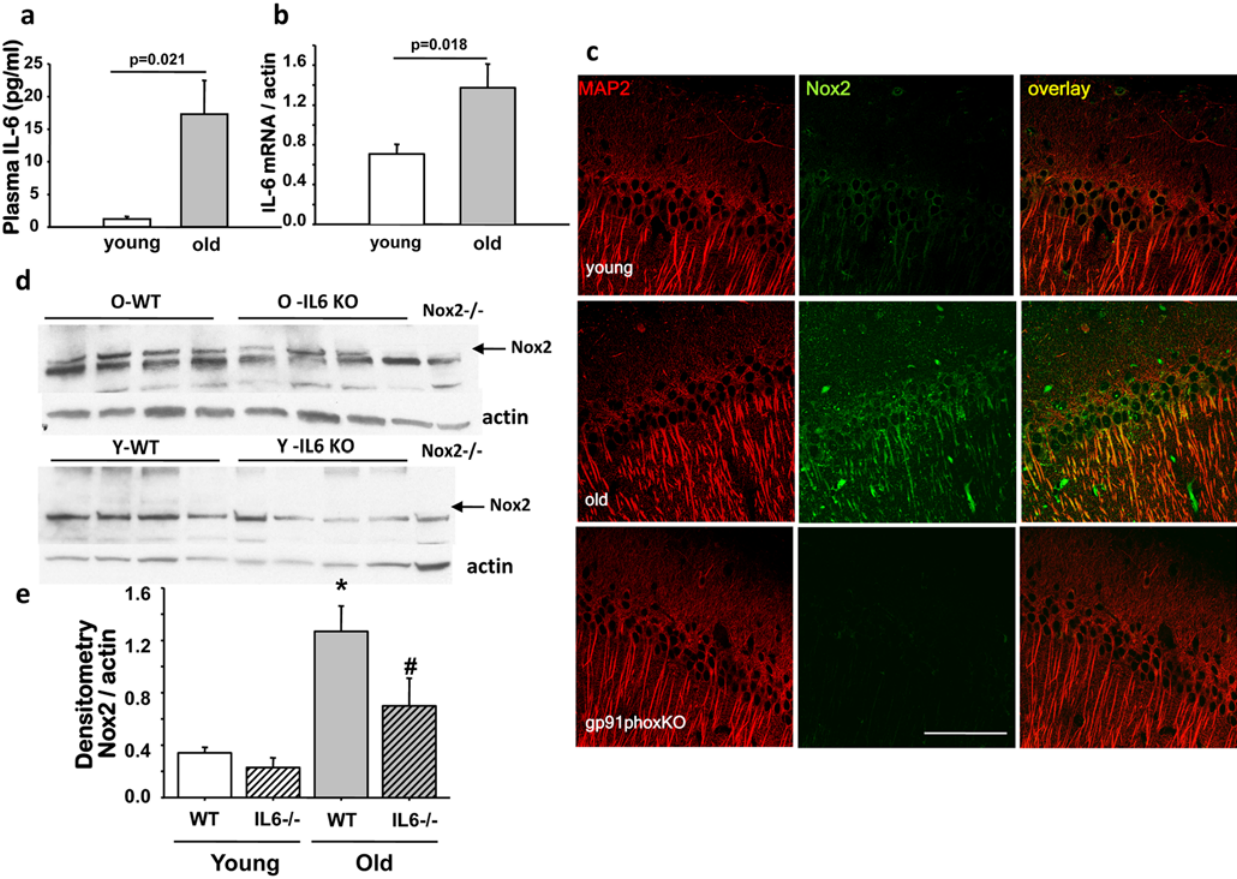
Figure 1. Aging increases plasma and brain levels of IL-6, and induces Nox2 protein expression which is blocked by targeted deletion of IL-6. (a) Plasma IL-6 was measured by ELISA in young (4 month) and old (24 month) C57BL6 mice and was significantly increased in old mice; n=4, mean 6 SEM (F (1,6) =9.530, P =0.021). (b) IL-6 mRNA expression was determined by real-time PCR in brain and was also increased significantly in old animals; n=4, mean 6 SEM (F (1,6) =10.288, P =0.018). (c) Confocal imaging of brain slices prepared from young (4 months) and old (23 months) mice depicting Nox2 (green) and MAP2 (red) immunoreactivity in the CA1 hippocampal region. Nox2 expression was increased in old animals with respect to young, whereas this staining was absent in slices prepared from Nox2-deficient ( gp91phox -/-, 12 months old) mice. Bar=100 m m. For immunofluorescence detection AlexaFluor 488 and 568 conjugated secondary antibodies were used. Merged images show co- localization in yellow. (d, e) Western blot analysis of brain protein extracts obtained from young and old wild-type and IL-6-/- mice showed increased Nox2 expression with age which was significantly lower in old IL-6-/- mouse brain (n=4, p , 0.05, mean 6 SEM). Expression in young animals, either WT or IL-6-/-, was below detection levels. Lack of the Nox2 band in brain proteins extracted from an old gp91phox-/- mouse (far right lane) confirmed specificity of the anti-Nox2 antibody and location of Nox2- specific band. N=4 animals per age per genotype (F (3,12) =9.704, P =0.002, *young versus old, P , 0.05; # old versus old- IL6-/- , P , 0.05 by